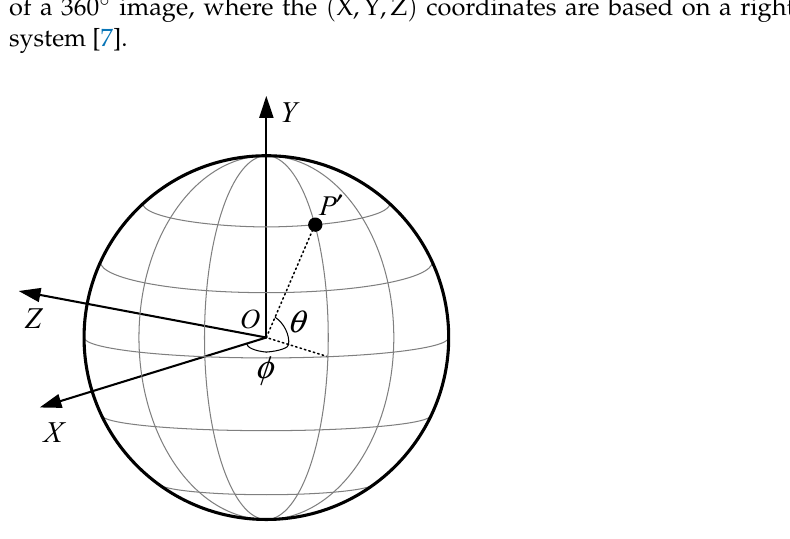
Figure 1. 3D XYZ coordinates used to describe the pixel location in the 360° image. The sphere can be sampled with the longitude ( ϕ ) and latitude ( θ ), where longitude ϕ is in the range of [ −π , π ], and latitude θ is in the range of [ −π /2, π /2]. In Figure 1, the longitude ϕ and latitude θ are defined by the angle starting from the X -axis and they move in a counter-clockwise direction and by the angle from the equator toward the Y - axis, respectively. The relationships between the (X,Y,Z) coordinates and ( ϕ , θ ) are de- scribed as follows [7]. X= cos ( θ ) cos ( ϕ )